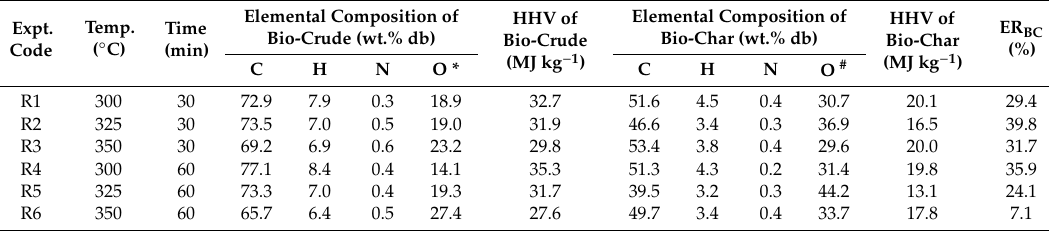
Table 3. E ff ect of final temperature and reaction time on elemental composition of bio-crude and bio-char, HHV of bio-crude and bio-char, and energy recovered in bio-crude. The rice-straw-to-water ratio is 1:10 wt. /